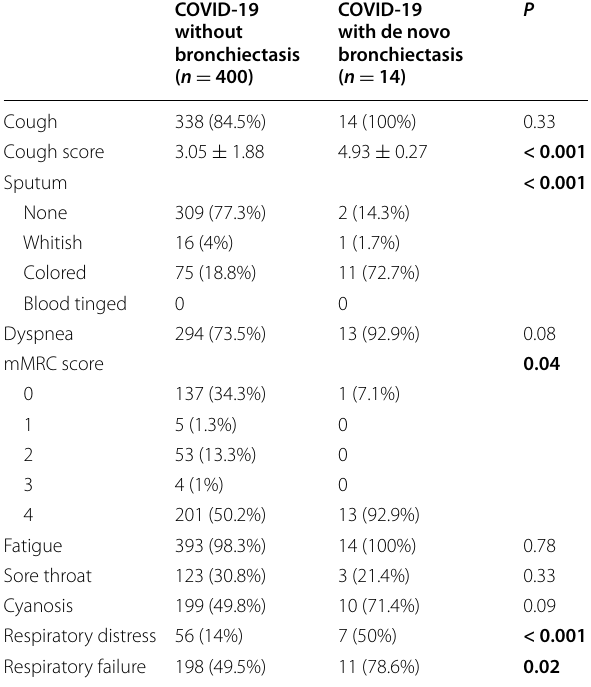
Data expressed as frequency (percentage), mean (SD). P value was significant if < 0.05